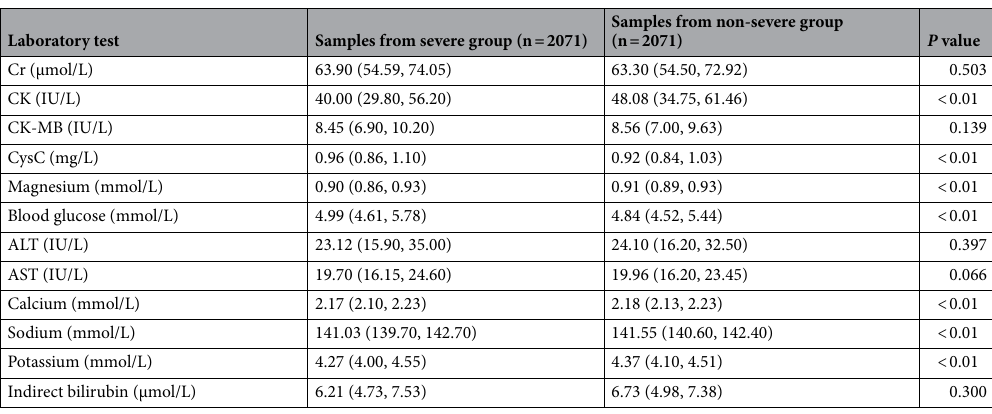
Table 2. Baseline characteristics for COVID-19 based on